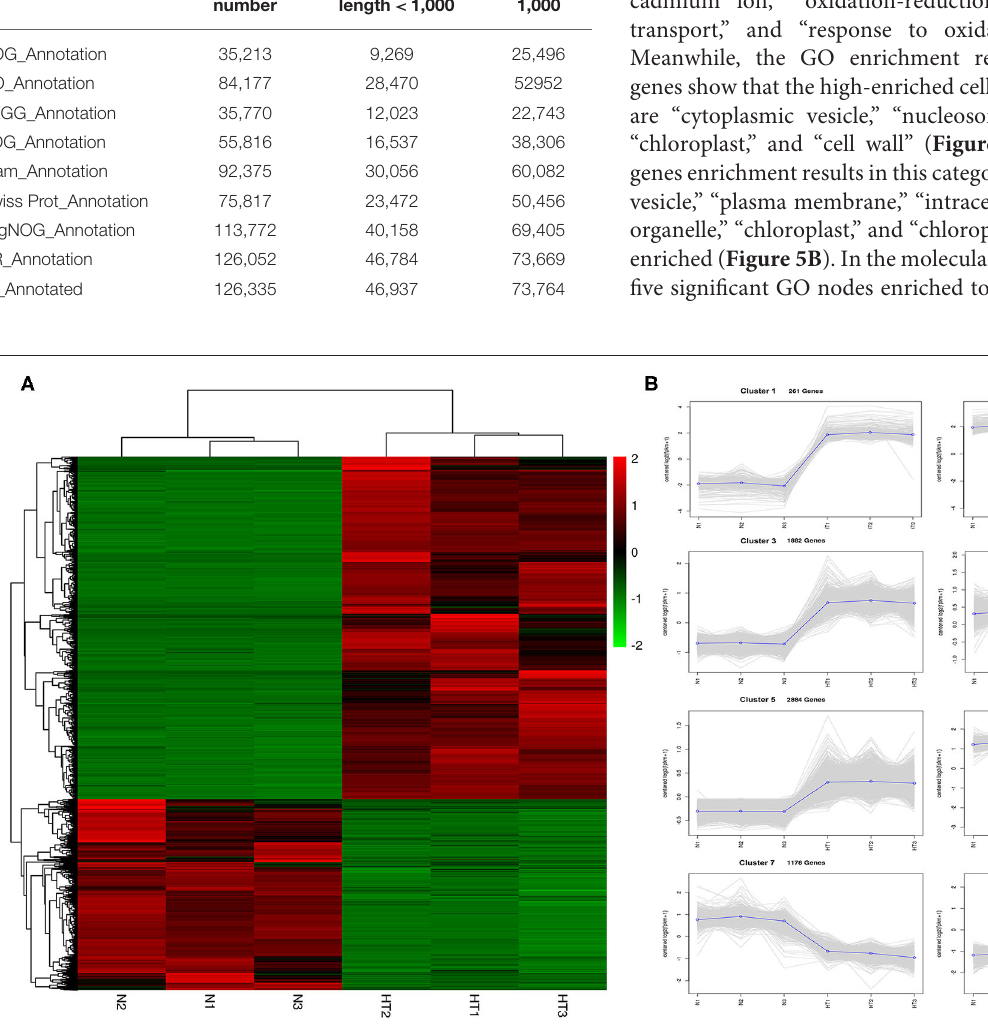
Frontiers in Plant Science |